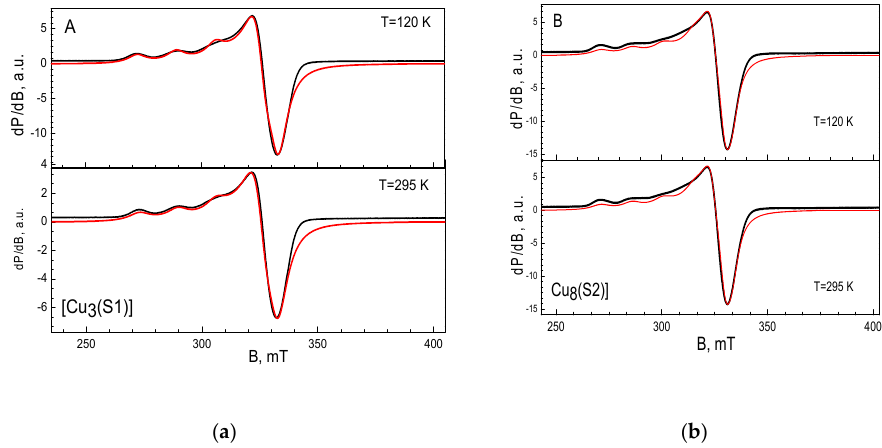
Figure 3. EPR spectra of [Cu 3 (S1)] ( a ) and [Cu 8 (S2)] ( b ) complexes. The black and red lines correspond to the experimental and simulated spectra,